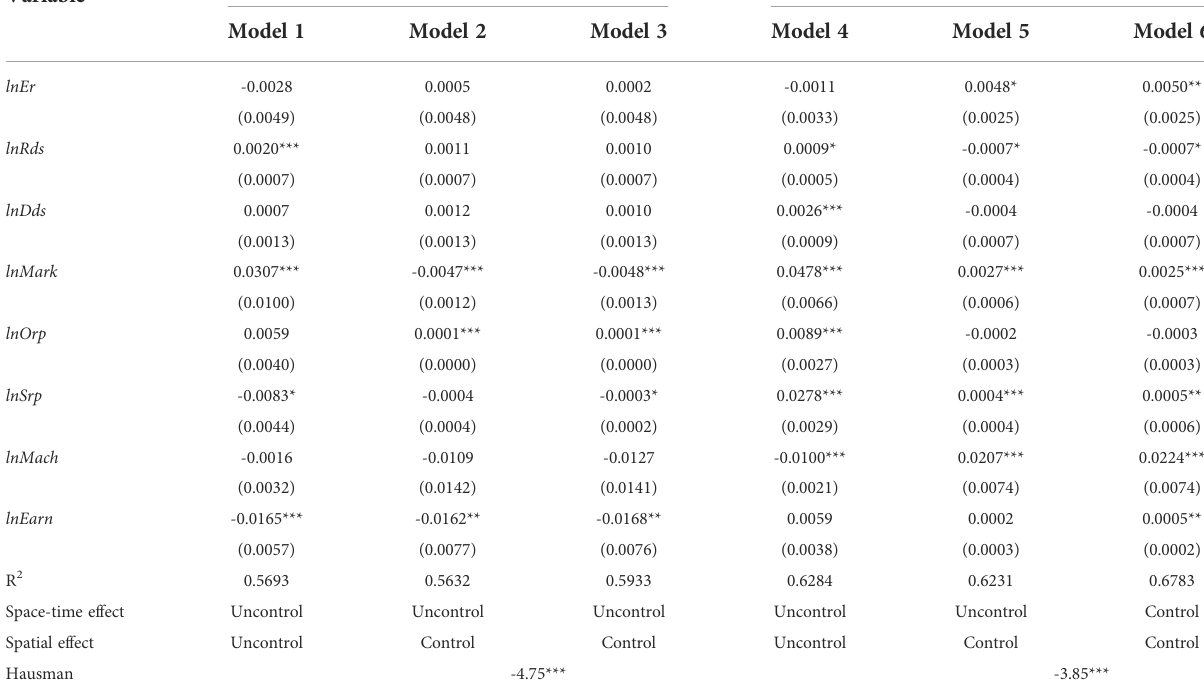
TABLE 5 Spatial Durbin Model (SDM) estimation results.